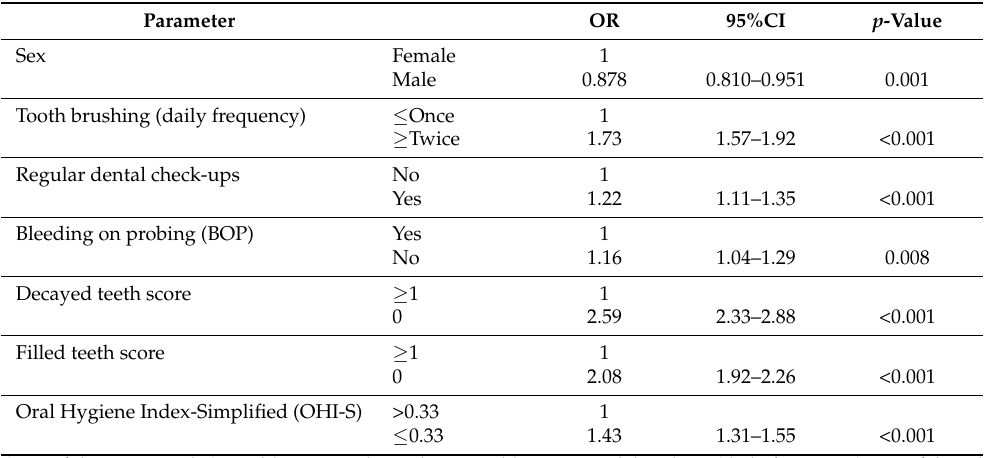
Table 3. Logistic regression analysis when independent variables were selected based on the p -value (<0.20) by the chi-squared test, Japanese university students, 2011–2019.